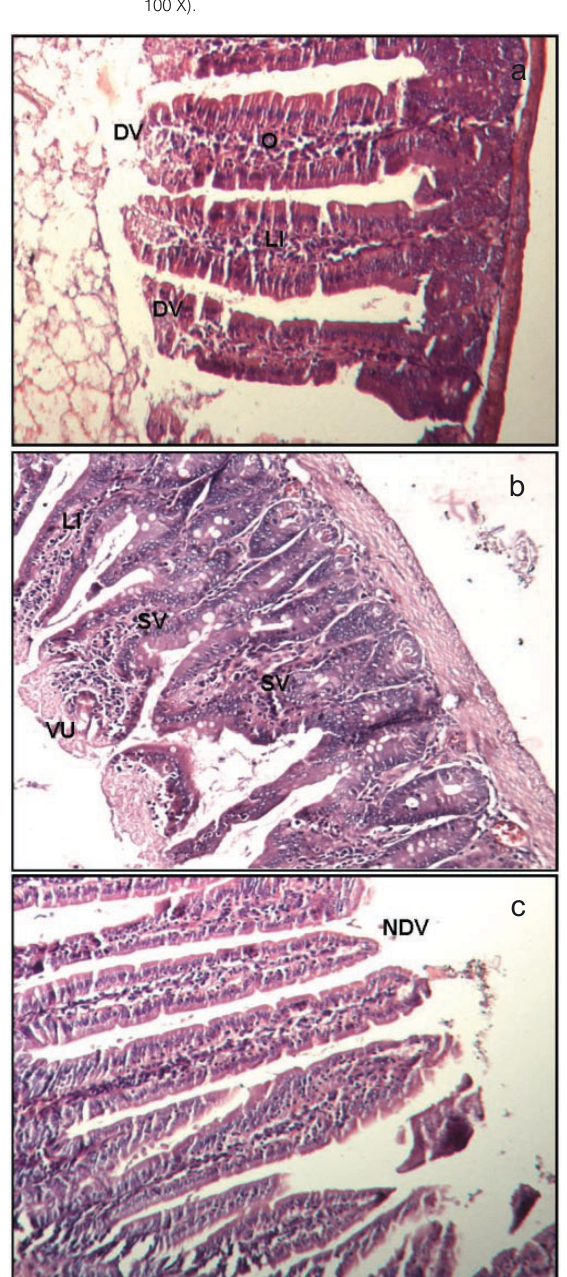
Figure 8. Photomicrograph of the small intestine of a Giardia - Probiotic mouse (Group V); a) on day 7 PI showing mild dissolutions of microvilli tips (DV), moderate hypertrophy of microvilli ,lymphocytic infiltration (LI) with thickened lumen (O); b) on day 14 PI showing broader swollen villus (SV), oedema, lymphocytic infiltration (LI) and dissolved microvilli: a case of villus ulcer (VU); c) on day 21 PI showing no disruption of the microvilli (NDV): normal microvilli structure. A high degree of lymphocytic infiltration (LI) in the microvilli with a minor number of lymphocytes extending into lamina propria, (H & E stain, 100